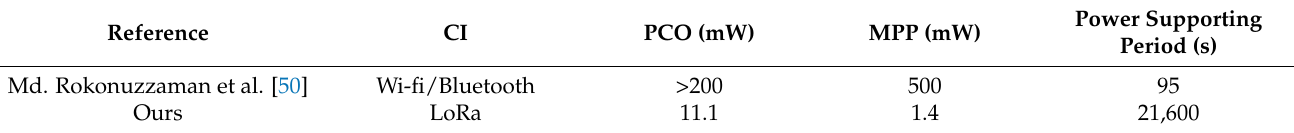
Table 4. A Comparison with the most related study where PCO is the Power Consumption at Operation